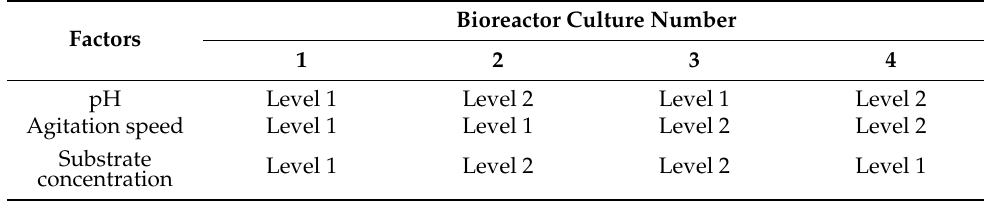
Table 1. The L4 orthogonal array for bioreactor cultures.